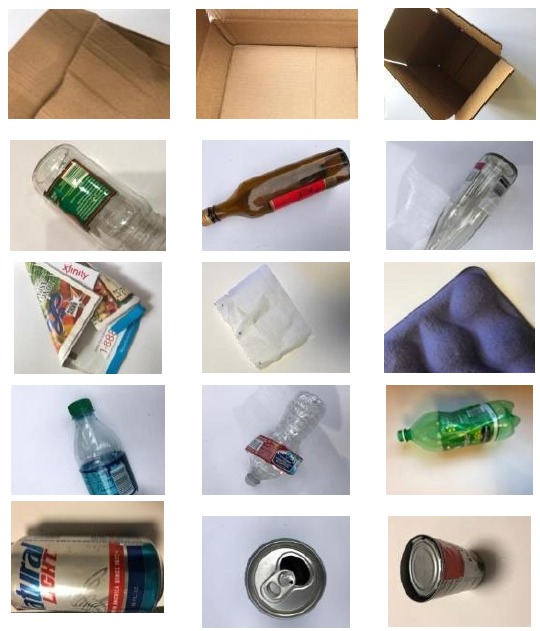
Figure 1. Images from training dataset.